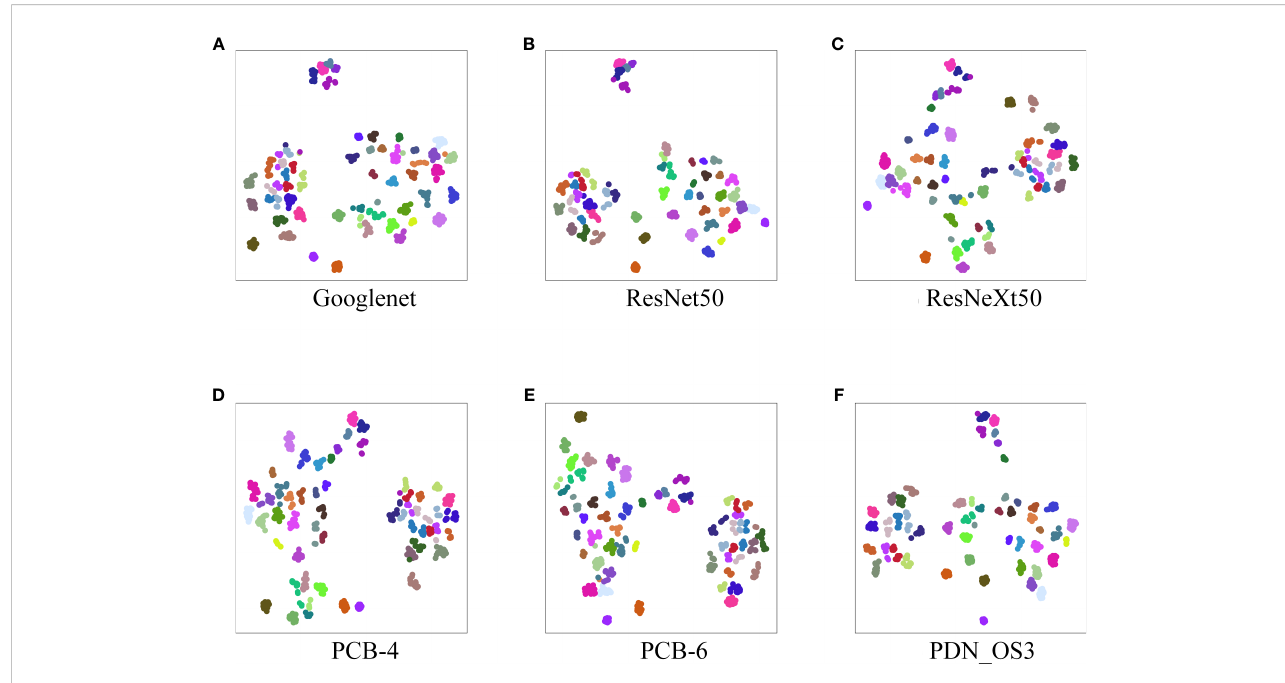
FIGURE 13 (A – F) Visualization of the classi fi cation ability of